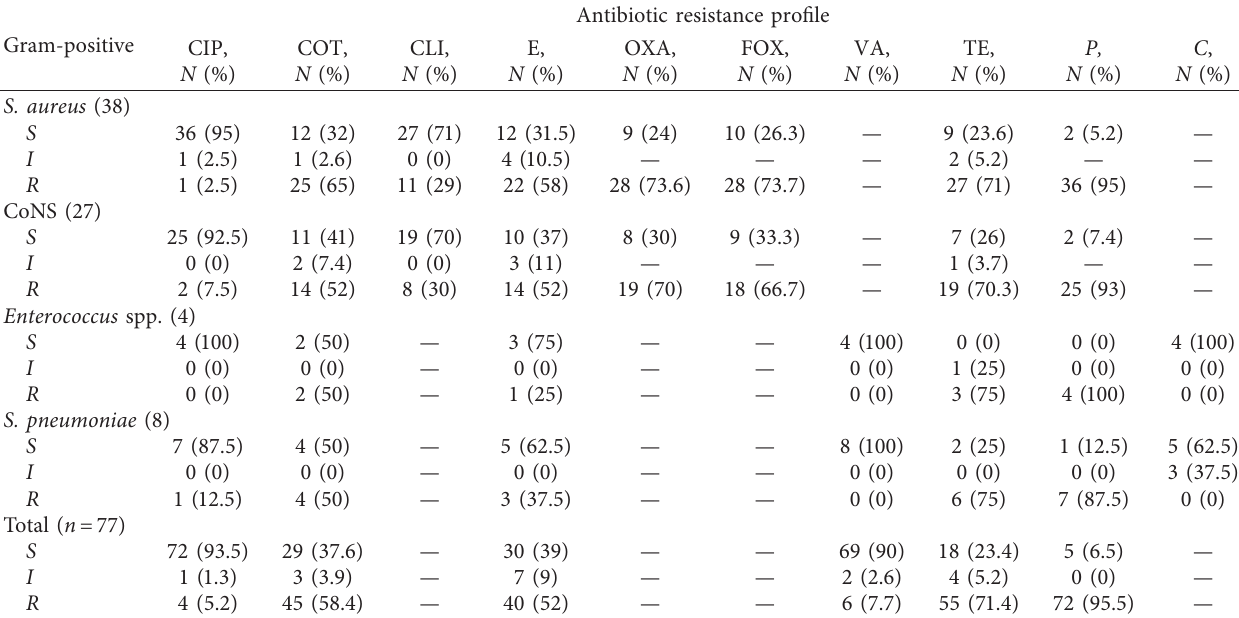
Table 2: Antibiotic resistance patterns of Gram-positive bacterial isolates among HIV/AIDS-infected patients at Felege Hiwot Referral